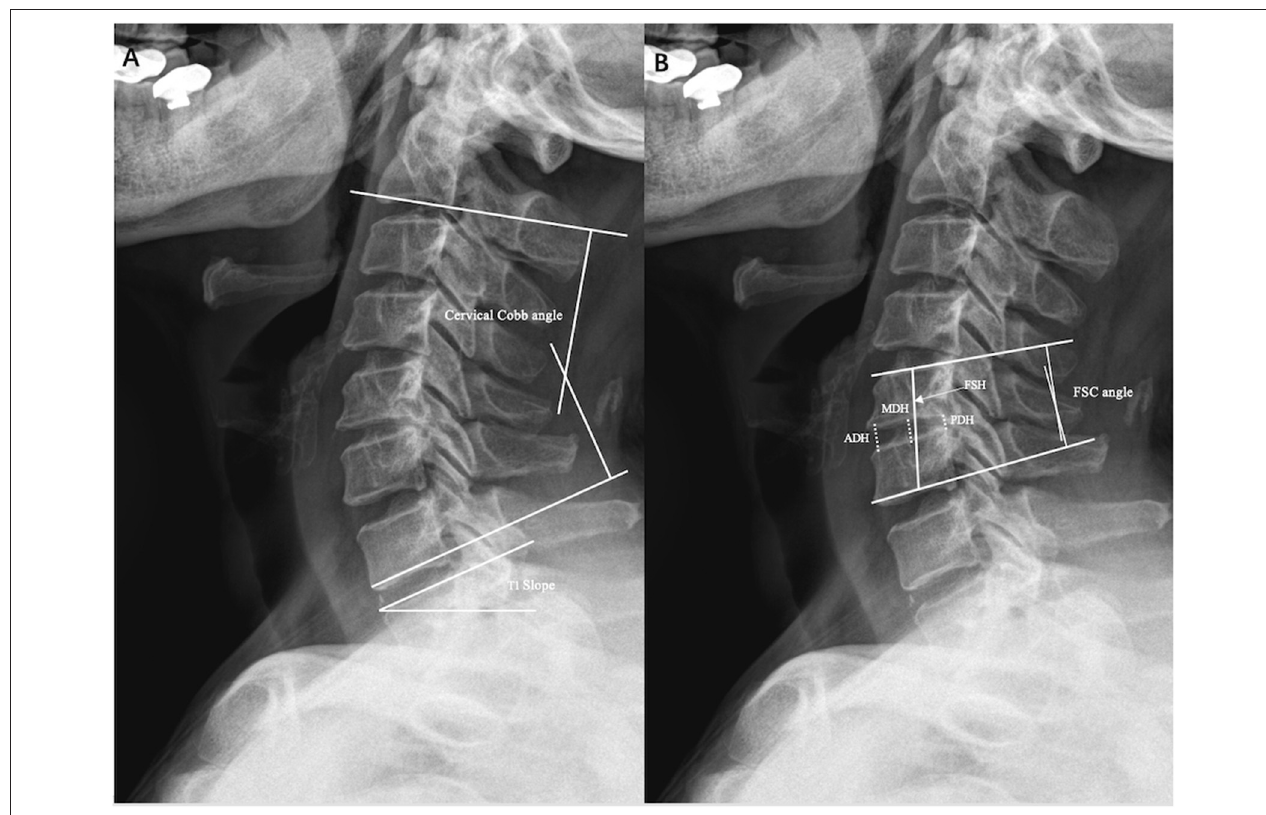
( Figure 1B ). Adjacent segment degeneration (ASD) was